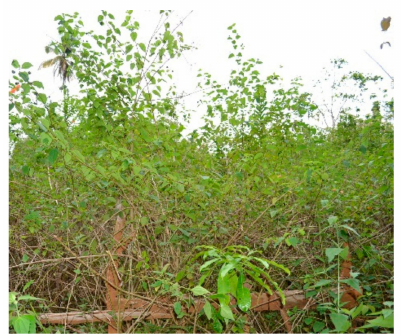
Figure 1. Photo of Patiwala